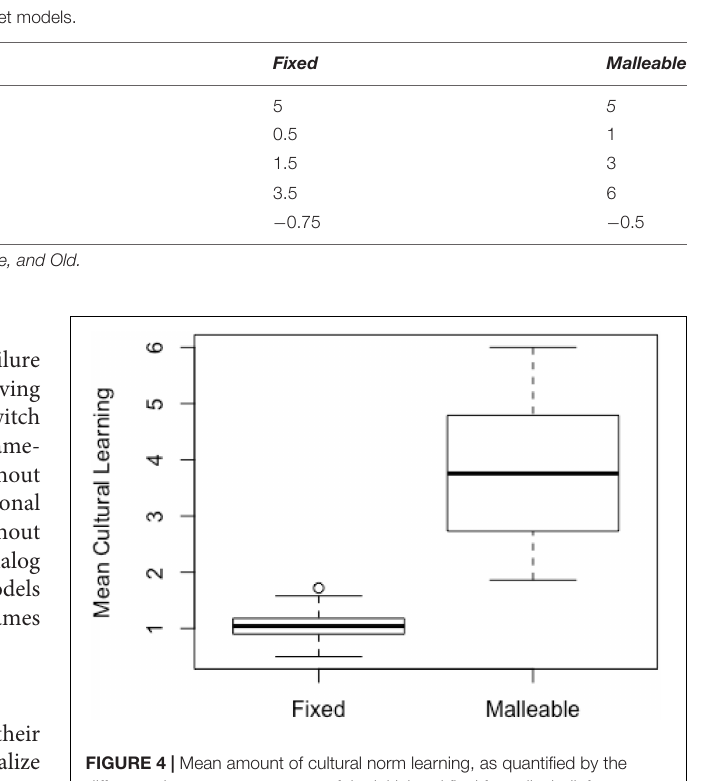
FIGURE 4 | Mean amount of cultural norm learning, as quantified by the difference between correctness of the initial and final formality beliefs, clustered by generating model. Each box represents the interquartile range with a median line and the whiskers represent 95% range given